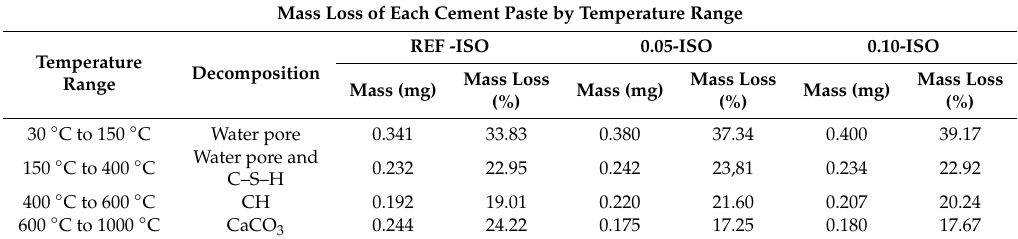
Table 5. Mass loss recorded by thermogravimetric